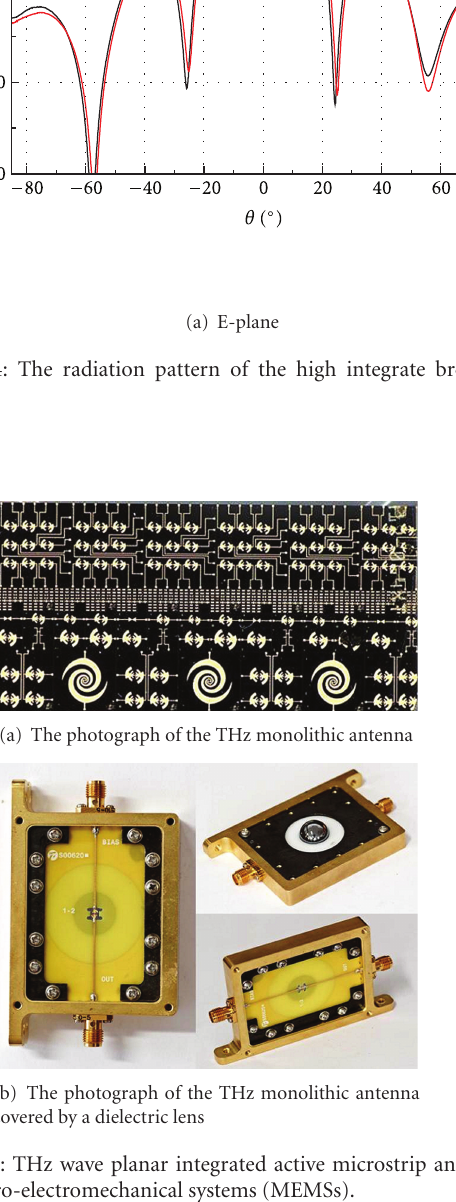
Figure 15: THz wave planar integrated active microstrip antenna using micro-electromechanical systems